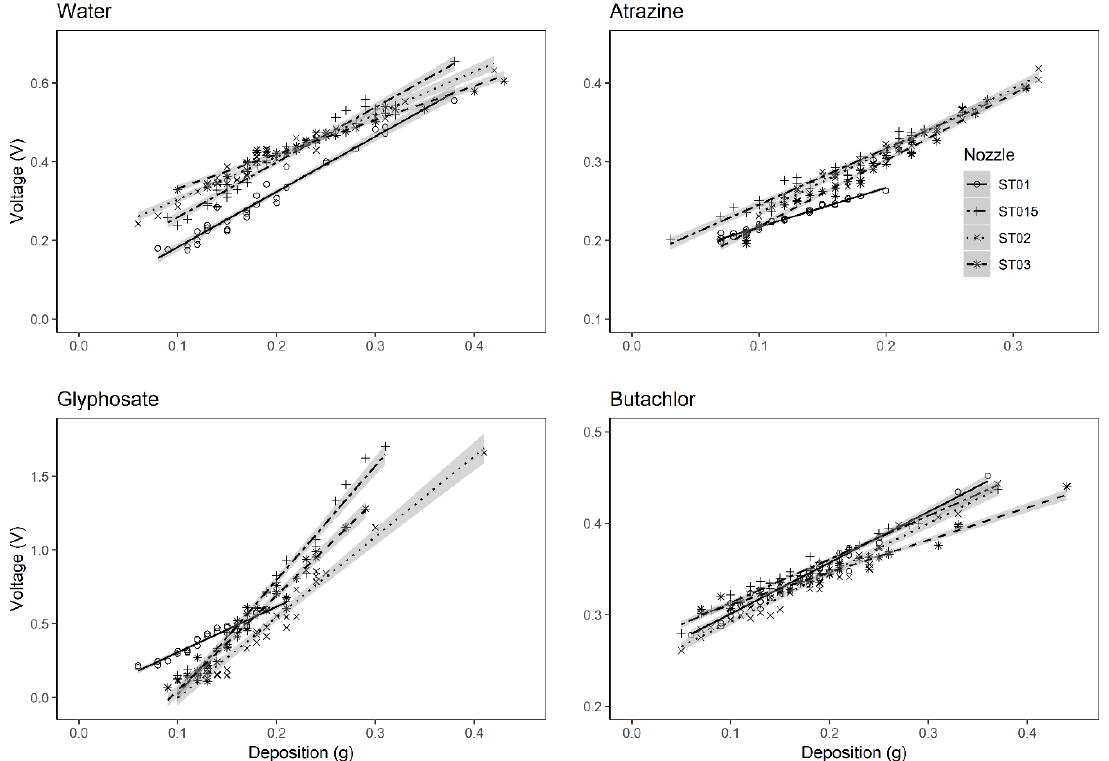
Figure 3. Linear regression models of the deposit data of sprays with herbicides in different formulations. The shadow area represents the standard error of the regressed linear models.